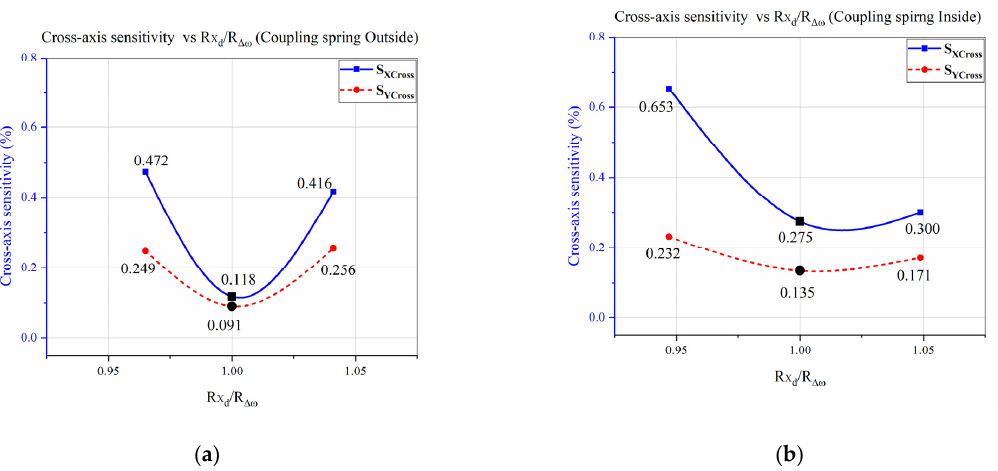
Figure 11. CAS vs. “ 𝑅 𝒙 𝝎 𝒅 / R ∆ ” w.r.t. Coupling Spring Position of the Designed MEMS Gyroscope. ( a ) Coupling Spring at the Outer Side; ( b ) Coupling Spring at the Inner Side